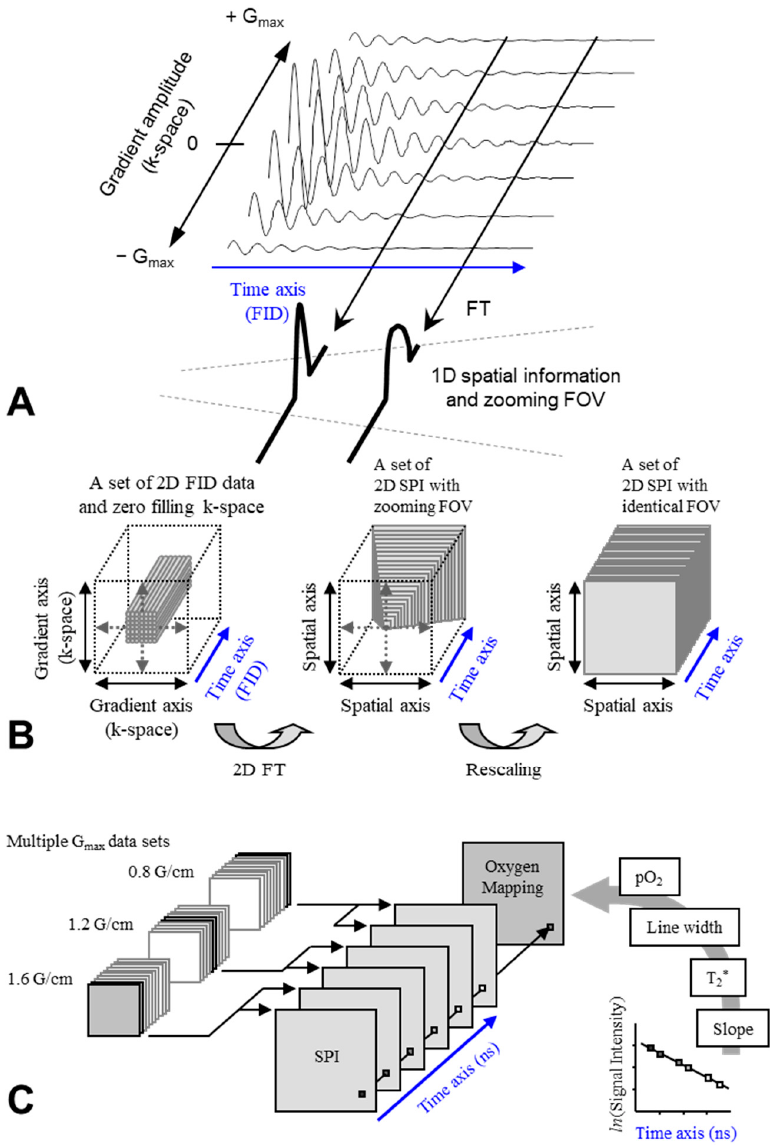
Figure 5. Spectral-spatial imaging in time domain. ( A ) A schematic drawing of theory of SPI basis 2D spectral-spatial imaging. Spectra (FIDs) are collected using incrementing but unidirectional field gradient strengths and a constant time window (sweep width in frequency domain). Fourier transformation along G axis gives a spatial profile. The FOV of the spatial profile is varied depending on the time. With combinations of two or three orthogonal field gradient set, 3D or 4D imaging is available. ( B ) A schematic drawing of data manipulation of 3D spectral-spatial imaging. Left: A set of FIDs measured under a 2D field gradient was placed on a 2D k-space and then the matrix was zero-filled (2n × 2n) for FT. Center: A set of 2D SPI, but delayed time points represent larger durations of the phase-encoding gradients and lead to lower Nyquist bandwidths corresponding to smaller FOVs (i.e., “zoomed-in” images). Gray slices indicate regions of identical FOVs for each time point. Right: All SPIs were rescaled to an identical FOV, and a 3D matrix (2D spatial and 1D time domain) was obtained. ( C ) Estimation of pixel-wise pO 2 from SPI data sets. An SPI data set was reassembled from several SPI data sets obtained by using multiple Gmax settings, to obtain a certain image resolution along the time axis. Pixels of reconstructed FID are replotted semilogarithmically, and the slope of the semilogarithmical plot of the FID gives T 2 *. The EPR linewidth, and then pO 2 can be calculated from the T 2 *. Finally, pO 2 values are rearranged onto a matrix (oxygen mapping). The figures were partly modified from our previous reports [74].